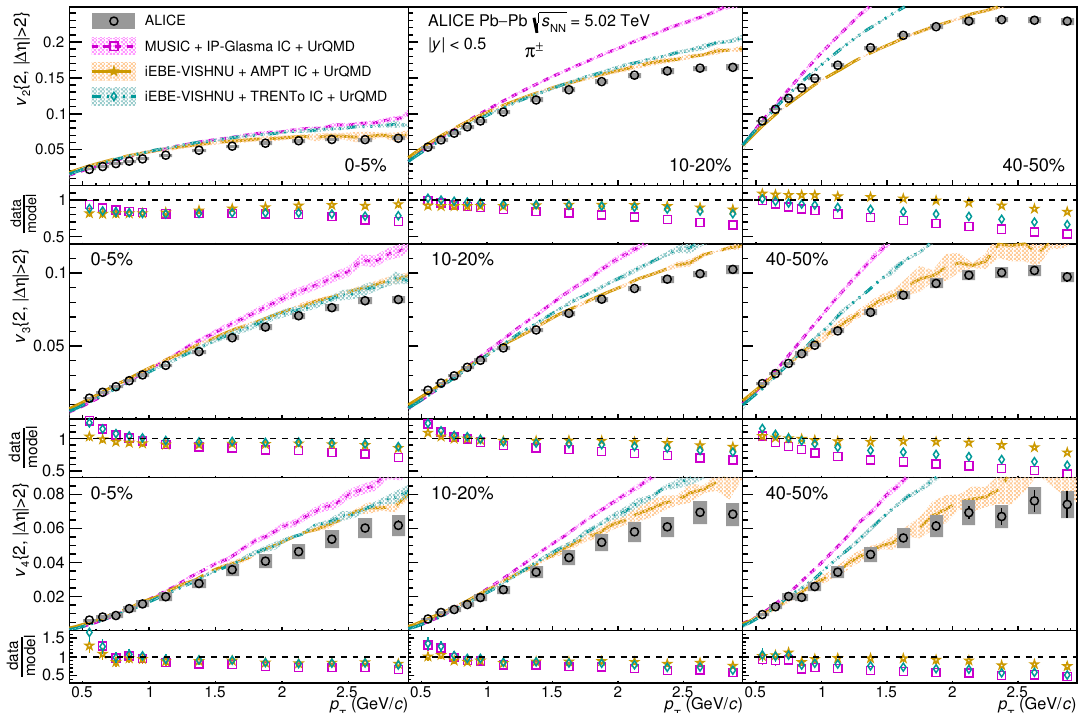
0.511.5 ode l a da t Figure 12 . (Colour online) The p T -di(cid:11)erential v 2 (top), v 3 (middle), and v 4 (bottom) of (cid:25) (cid:6) for the 0{5%, 10{20%, and 40{50% centrality classes compared to hydrodynamical calculations from MUSIC model using IP-Glasma initial conditions (magenta) [82] and the iEBE-VISHNU hybrid model using AMPT (orange) or TRENTo (cyan) initial conditions [83]. Statistical and systematic uncertainties of the data points are shown as bars and boxes, respectively. The uncertainties of the hydrodynamical calculations are depicted by the thickness of the curves. The ratios of the measured v n to a (cid:12)t to the hydrodynamical calculations are also presented for clarity. between (cid:25) (cid:6) and K (cid:6) v and iEBE-VISHNU calculations for p < 2 GeV =c , while p+p v n T